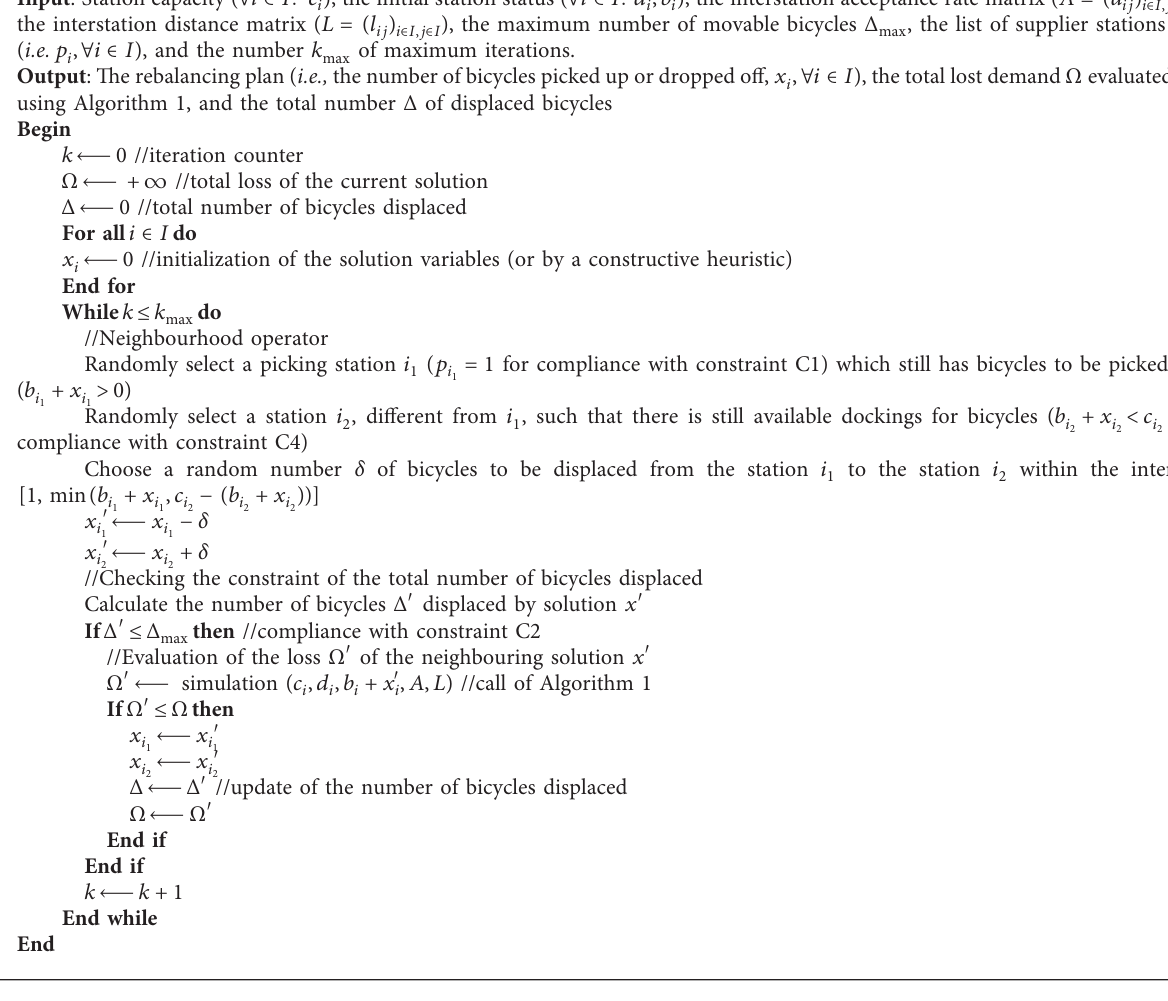
A LGORITHM 2: Optimization algorithm by metaheuristic (Random Search) using Algorithm 1 for lost demand evaluation.